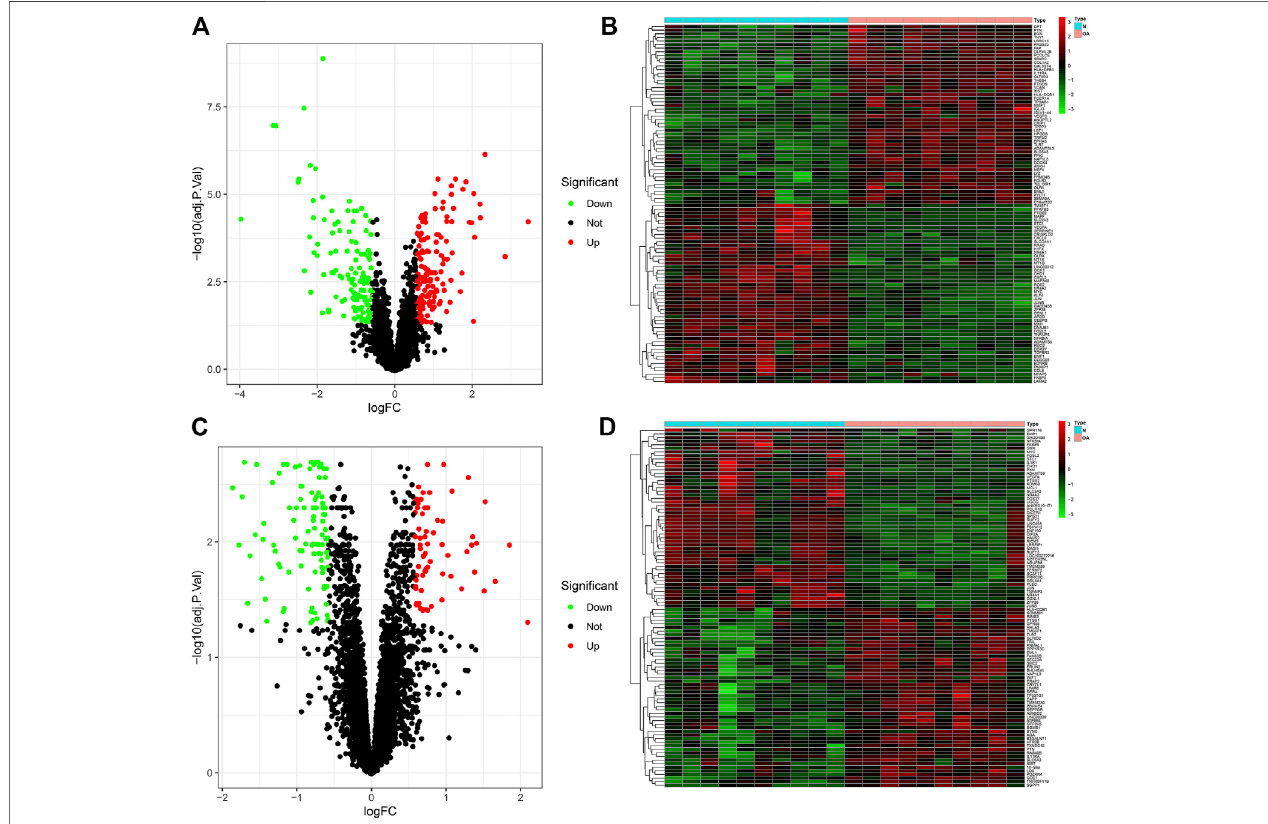
FIGURE 1 | Identifying DEGs in osteoarthritic and healthy synovial tissues in the GSE55235 and GSE55457 datasets. (A,B) Volcano and heatmap for visualizing up- (red) and down-regulated (green) genes in osteoarthritic compared to healthy synovial tissues in the GSE55235 dataset. Black spots indicate non-DEGs. (C,D) Volcano and heatmap showing up- (red) and down-regulated (green) genes between OA and control synovial tissues in the GSE55457 dataset.